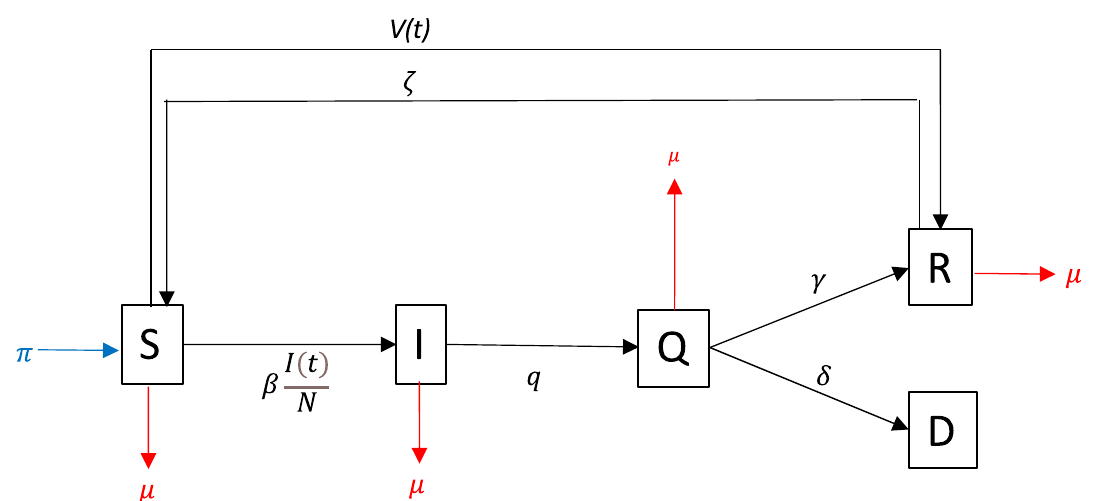
Figure 1. The SIQRD model applied in this study. S, susceptible; I, infected; Q, quarantined; R, recovery; D, death. Black arrows represent the logic flow of infection using SQRD model. Blue arrows represent natural recruitment ( π ). Red arrows represent the death rate ( µ ). The detailed description of variables is shown in Appendix A.